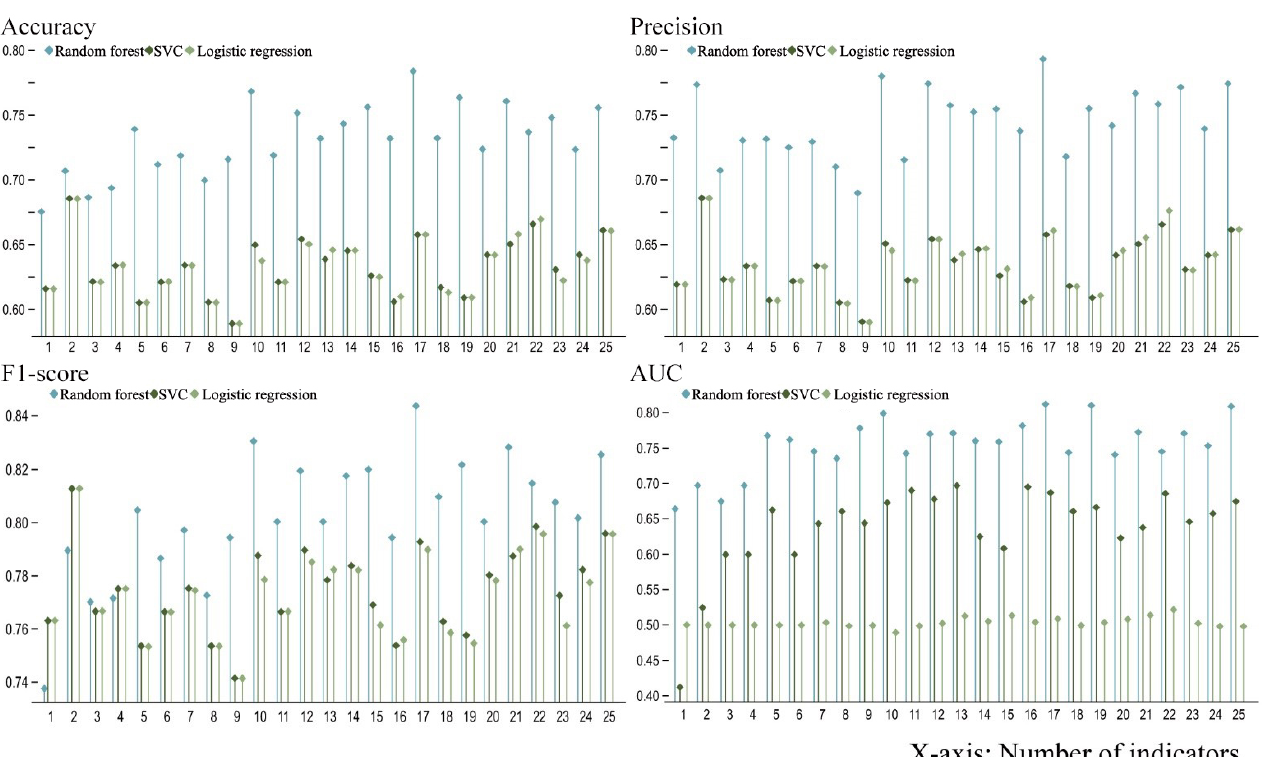
Figure 6. Comparison of the parameters of random forest, Support Vector Classification (SVC), and logistic regression models.